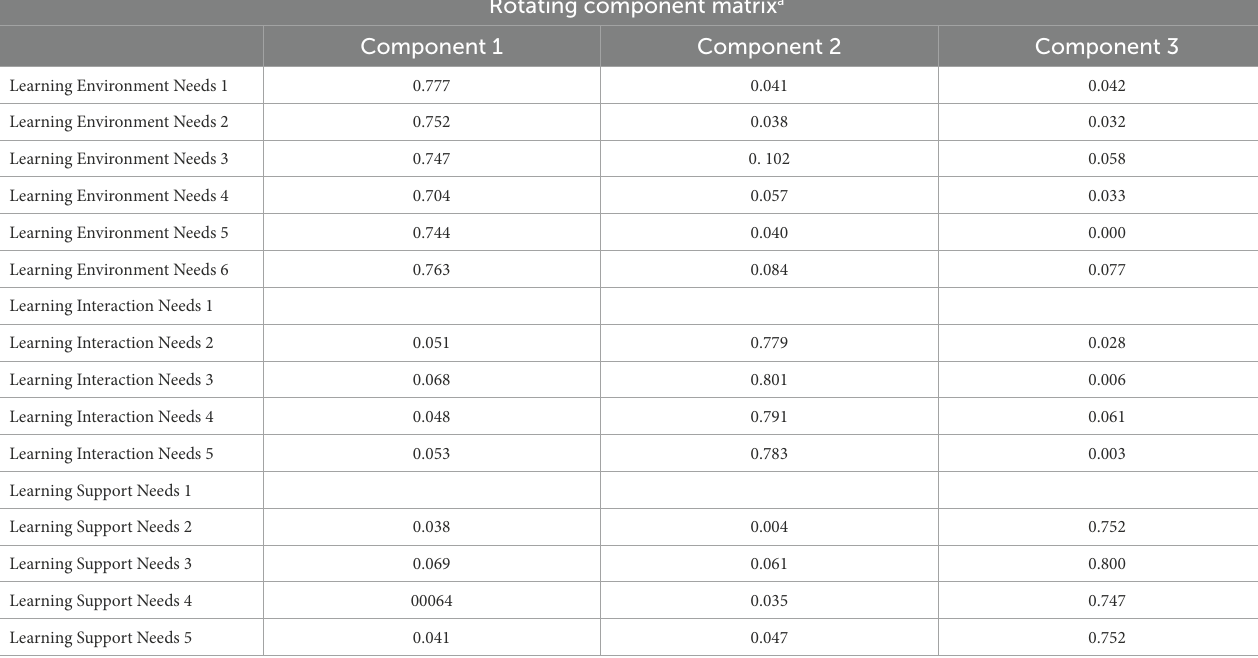
TABLE 7 Calculation results of orthogonal rotation of demand size index.